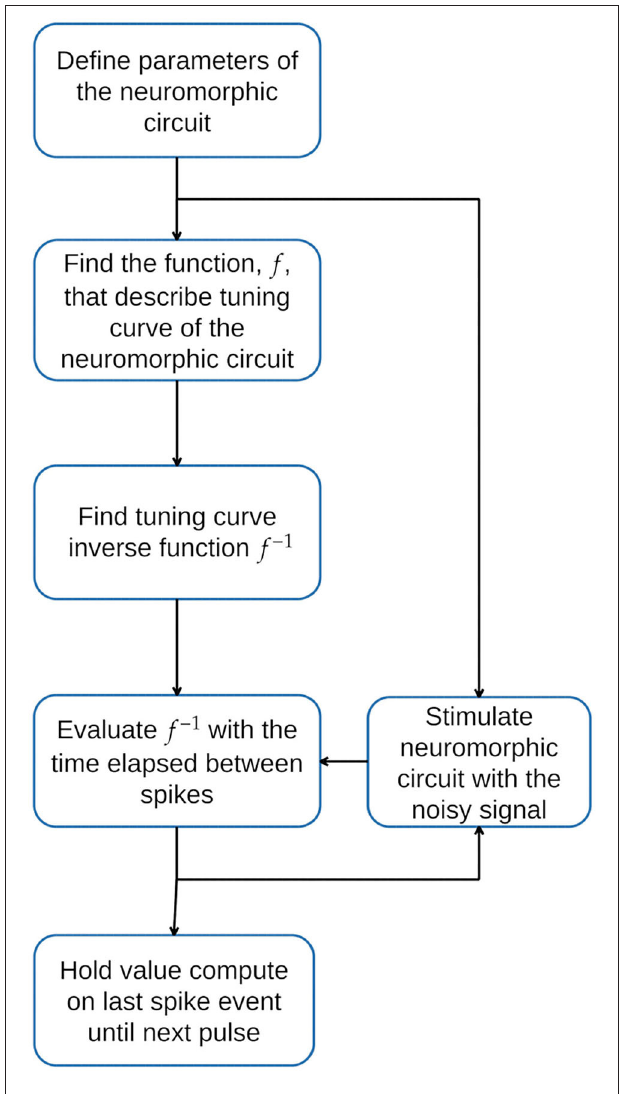
FIGURE 3 | Proposed Methodology. First, define the parameters of the neural circuit. Second, characterize the response to obtain the circuit tuning curve function, f , and its inverse function. Finally, stimulate the neural circuit with the noisy input signal and use the time elapsed since the last spike to evaluate the inverse function f − 1 . The value computed using f − 1 is held until the next event